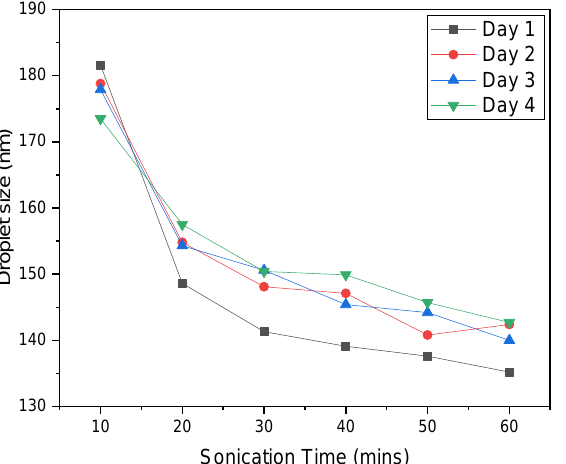
Figure 6. The dependence of the droplet size on the sonication time and the duration of emulsion storage (until four days).